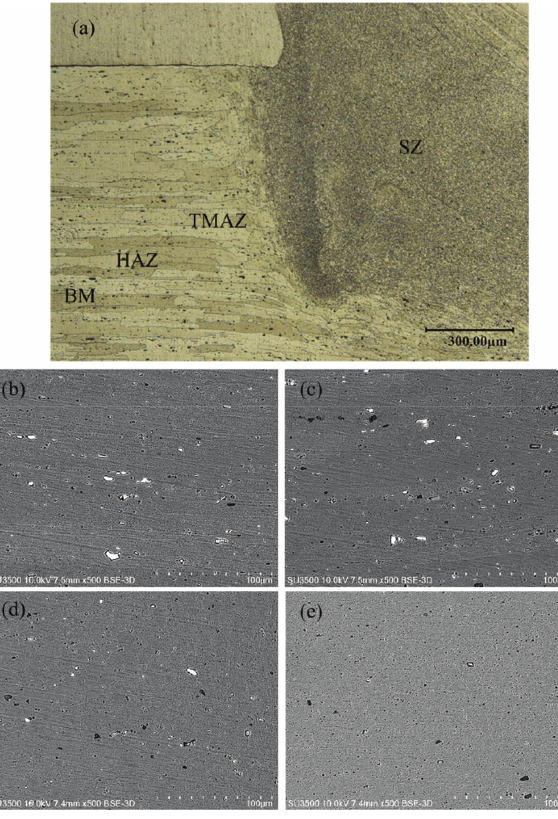
Figure 7: Secondary phases near the maximum plunge depth region: (a) the general view, (b) BM, (c) HAZ, (d) TMAZ and (e) SZ.